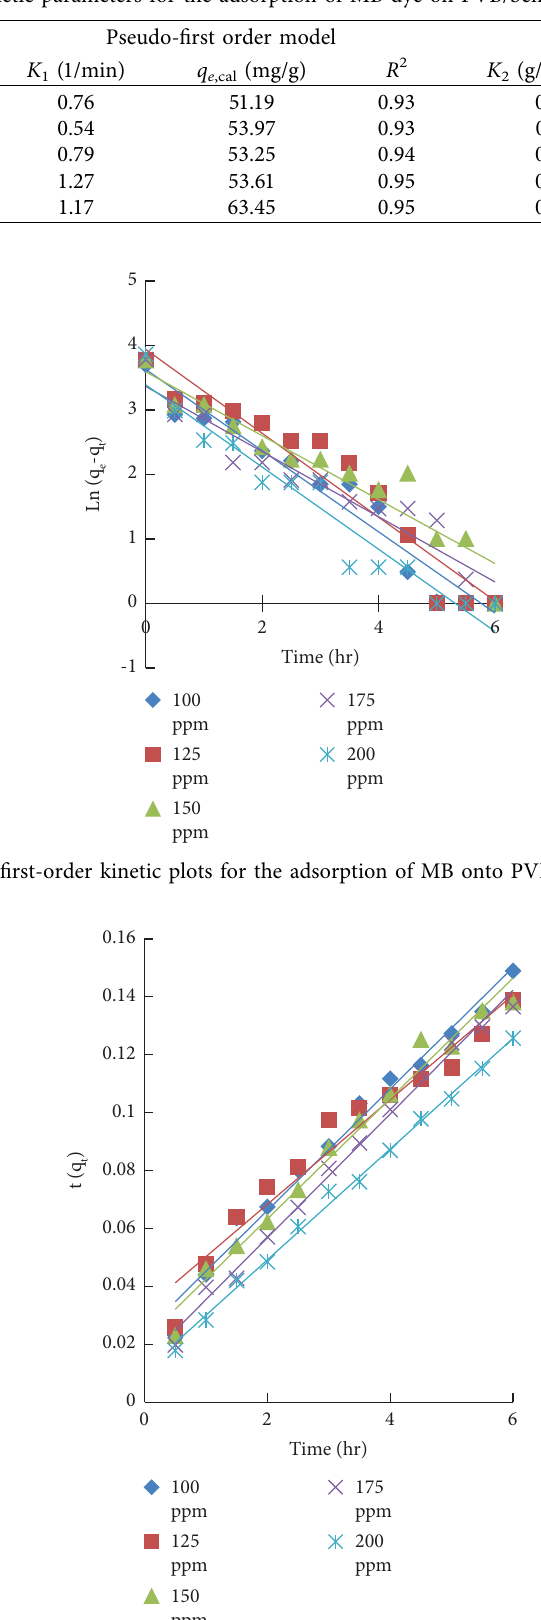
Table 5: Kinetic parameters for the adsorption of MB dye on PVB/bentonite nanofbers.